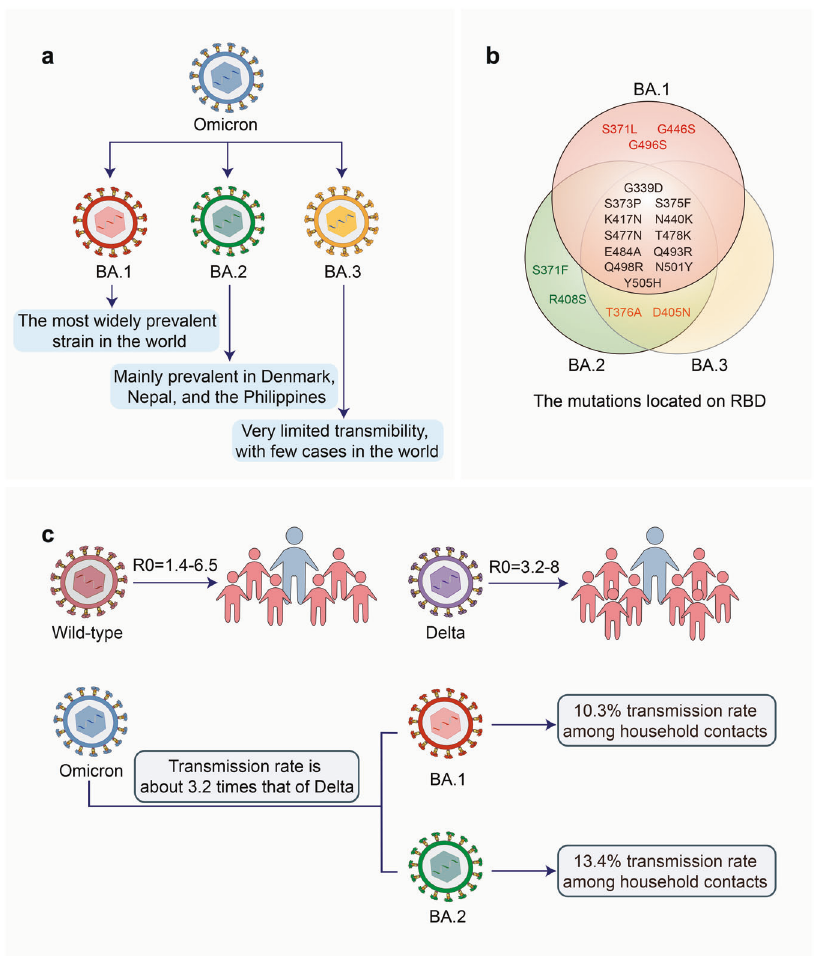
Fig. 1 The sub-lineages of the SARS-CoV-2 Omicron variant. a The Omicron variant has evolved into three sub-lineages: BA.1, BA.2, and BA.3. b Venn diagram showing the mutations located on the S protein RBD of BA.1, BA.2, and BA.3. c Transmission speed of SARS-CoV-2